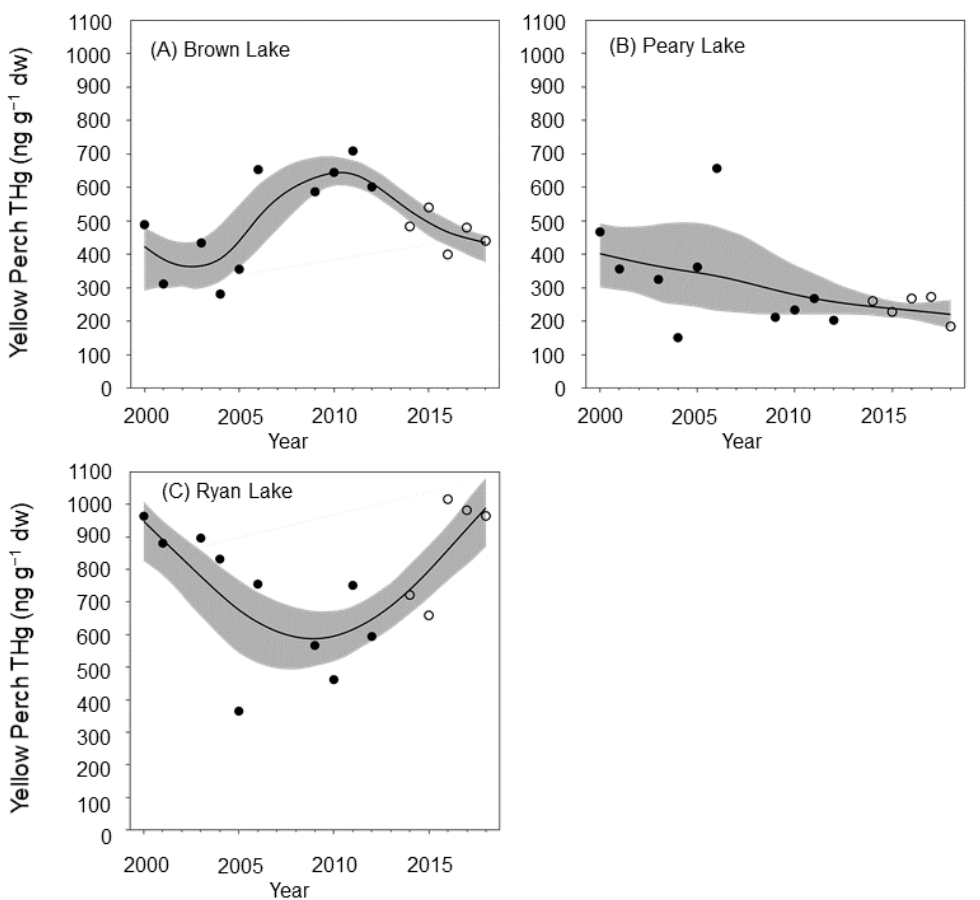
Figure 8. Total mercury (THg) in age-1 yellow perch versus time in ( A ) Brown Lake, ( B ) Peary Lake, and ( C ) Ryan Lake. Solid symbols represent geometric mean concentrations from yellow perch, open symbols indicate that yellow perch concentrations are derived from dragonfly larvae using the linear regression shown in Figure 7. Shaded area shows the 95-percent confidence interval. [Smooth lines are locally weighted regression. Smoothing parameters: ( A ) Brown Lake = 0.75; ( B ) Peary Lake = 0.83; and ( C ) Ryan Lake = 0.76. Gray shading indicates the 95-percent confidence interval.